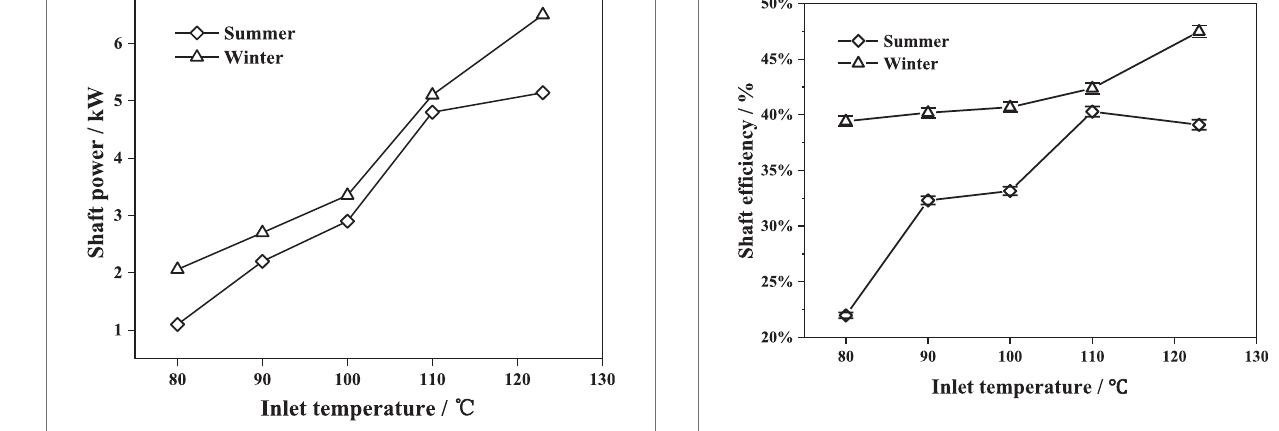
FIGURE 5 | The variation of shaft power with inlet temperature.